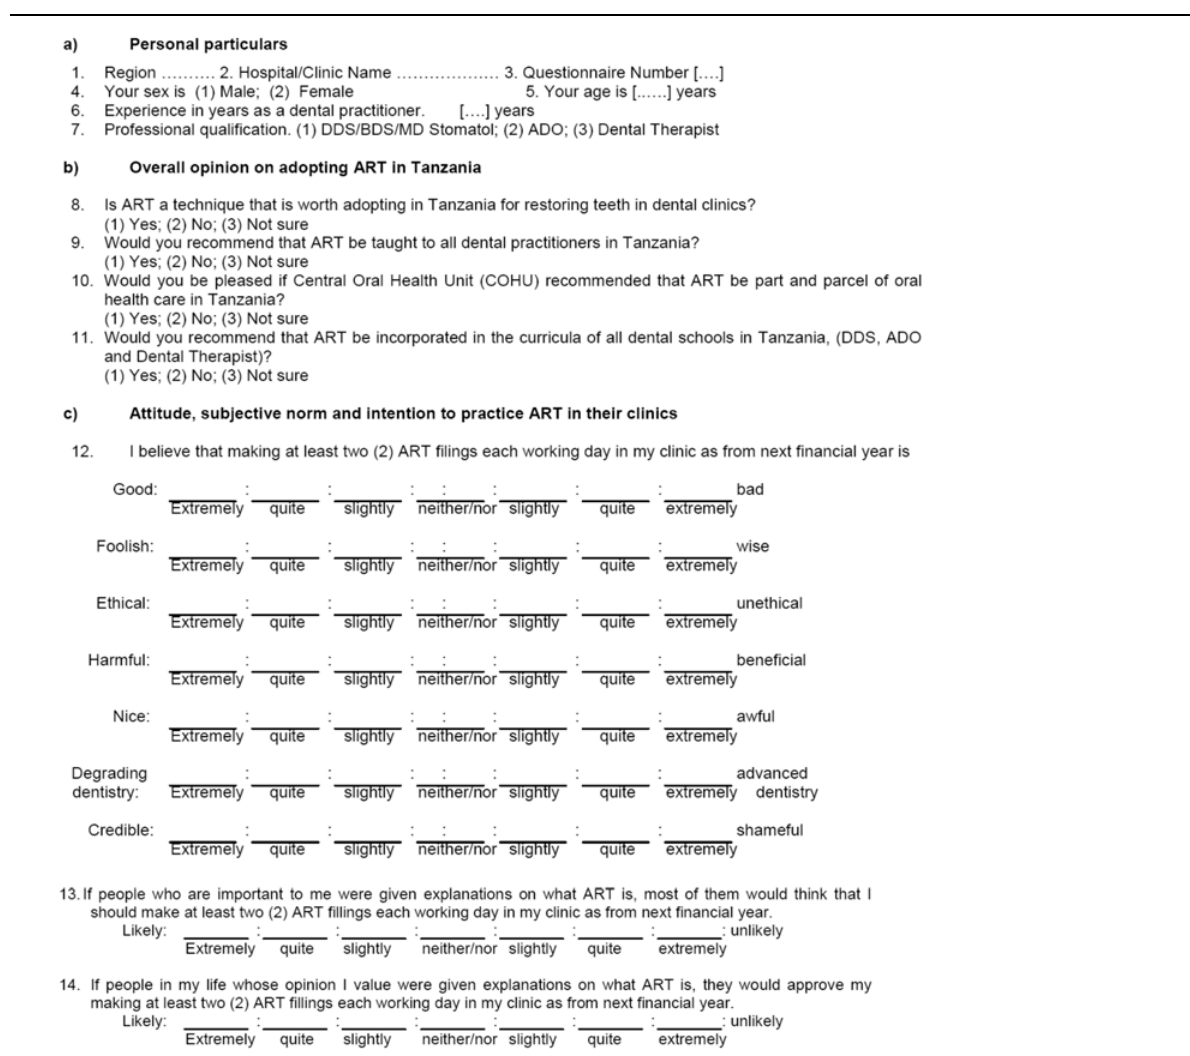
TABLE 1- Questionnaire on opinion of dental practitioners regarding the introduction and adoption of ART in daily clinical practice in